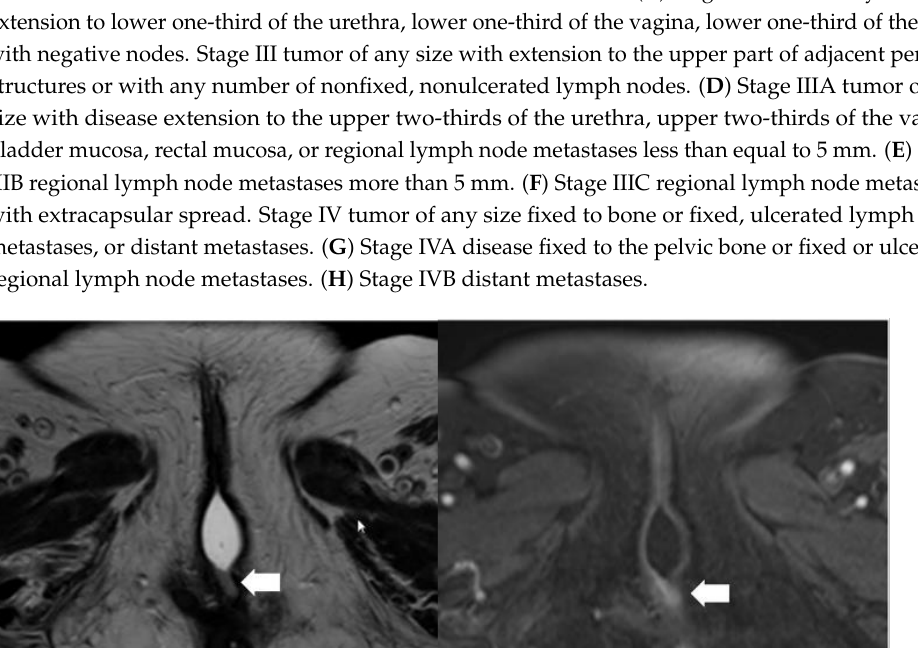
Figure 4. FIGO stage IB. A 52-year-old female with squamous cell carcinoma of the vulva. ( A ) Axial T2 weighted image and ( B ) post-contrast fat-saturated axial T1 weighted MRI image showing an enhancing 3.4 × 2.3 cm T2 intermediate signal biopsy-proven vulvar tumor (arrow). 5.2. Stage II Stage II represents any sized tumor extending to the lower one-third of the urethra, vagina, or anus without metastases to lymph nodes. There are no additional revisions in this stage from FIGO 2009 classification (Tables 4 and Figure 5). In addition to the size of the tumor, MRI assesses the extension of locally advanced vulvar cancer to superficial (labia majora and minora and clitoris) and deep structures (urethra, vagina, and anus). Clinical examination alone is challenging in patients with urethral involvement and ab- sent clinical findings. In such cases, disruption of the target appearance of the urethra on T2WI and contrast-enhanced T1WI is suggestive of a urethral infiltration [26].